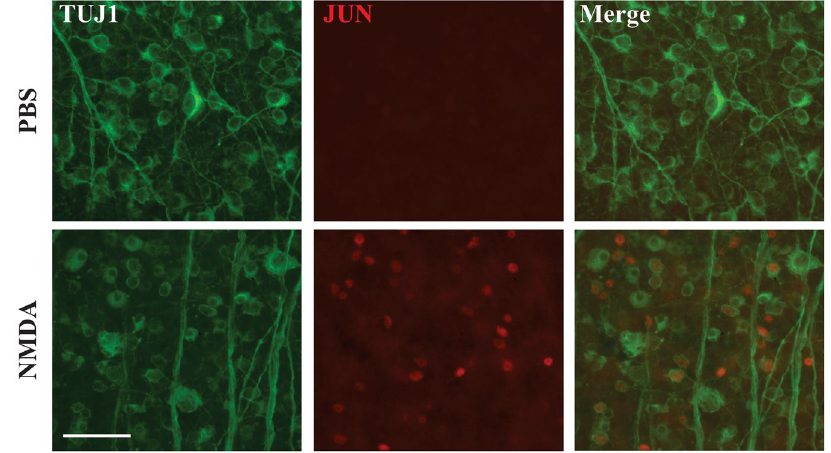
Figure 4. JUN signaling is activated in retinal cells in vivo following intravitreal injection of NMDA. Excitotoxic injury causes JUN activation as represented by pJUN in retinal cells, specifically RGCs, 6 hours after intravitreal injections of either NMDA. Representative images of retinal flat mounts stained with TUJ1 and JUN 6hrs after NMDA injection, showing activation of JUN in TUJ1 + cells (n = 3 for each condition). Scale bar, 50 μ m.